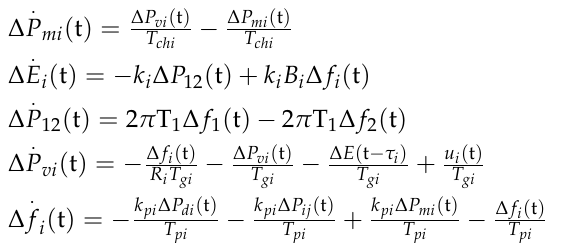
Figure 2. Block diagram of a two-area power system.